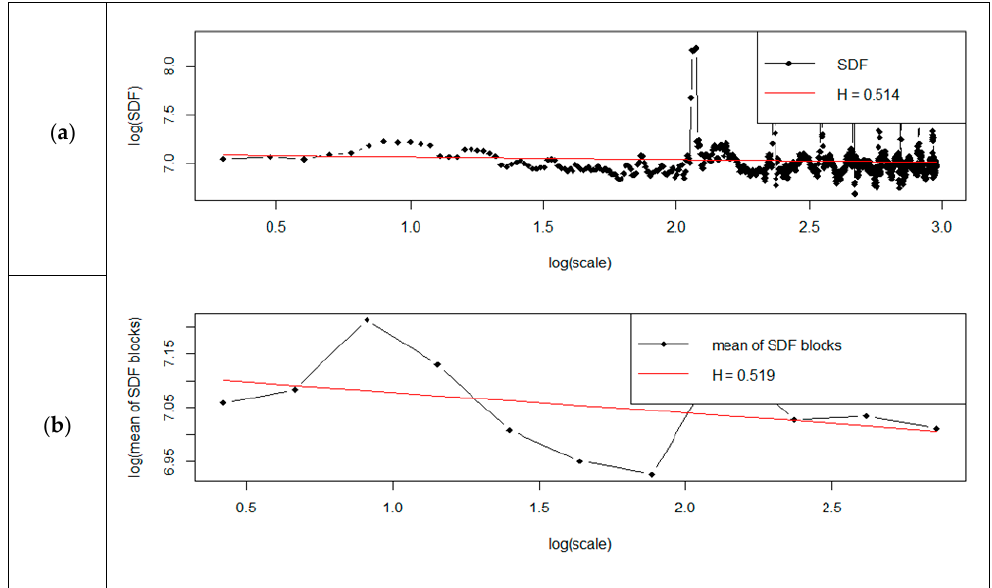
Figure 14. Spectral regression graph by multitaper method: ( a ) the standard method, ( b ) the smoothed method.